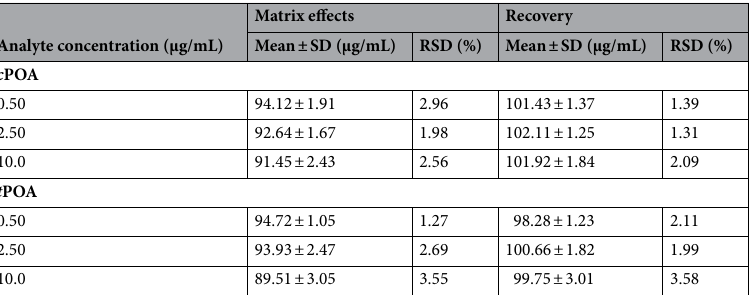
Analyte concentration